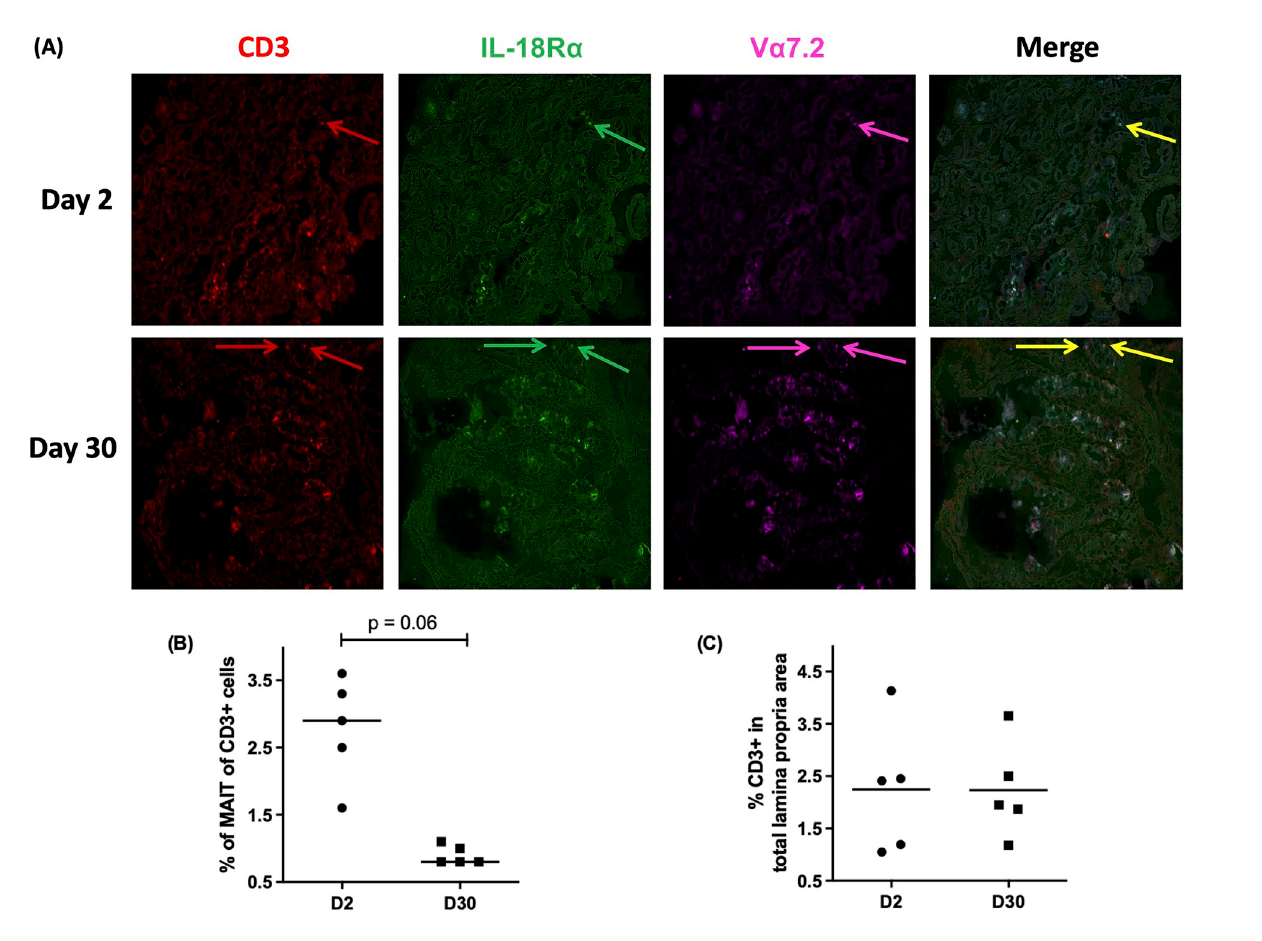
Fig 1. MAIT cell localization and frequency in LP by Immunohistochemistry. Cryosections of duodenal biopsies obtained from five cholera patients (n = 5) were stained with antibodies as mentioned in methods and imaged using Leica CM3000 Cryostat. (A) Representative images of duodenal biopsies at day 2 and day 30, shows CD3 + T cells (red arrows), IL-18R α + T cells (green arrows), V α 7.2 + cells (magenta arrows), and the merged image shows MAIT cells (yellow arrows indicating CD3 + IL-18R α + V α 7.2 + cells). (B) Frequency of MAIT cells, as a % of total CD3+ cells in the duodenum at day 2 and day 30 post infection (p. i.), and (C) Frequency of CD3 + cells, as % of total cells in the lamina propria area at day 2 and day 30 p.i. Statistical significance of the difference between day 2 and day 30 was determined using the Wilcoxon signed-ranked